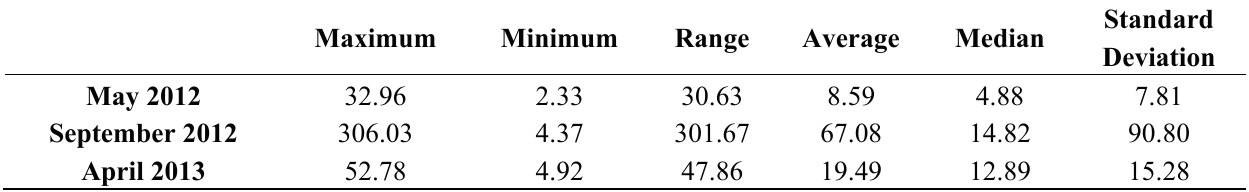
Table 1. Summary statistics for chl- a (concentrations in µg·L − 1 ) at each campaign. Maximum Minimum Range Average Median